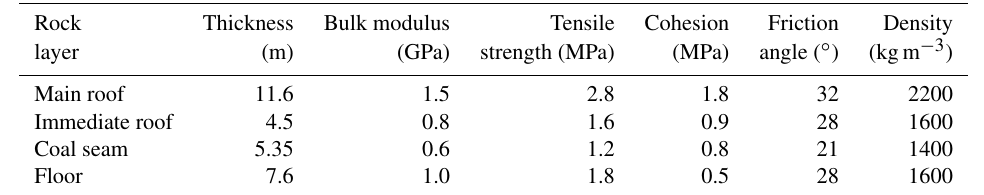
Table 2. Physico-mechanical parameters of the coal and rock mass.